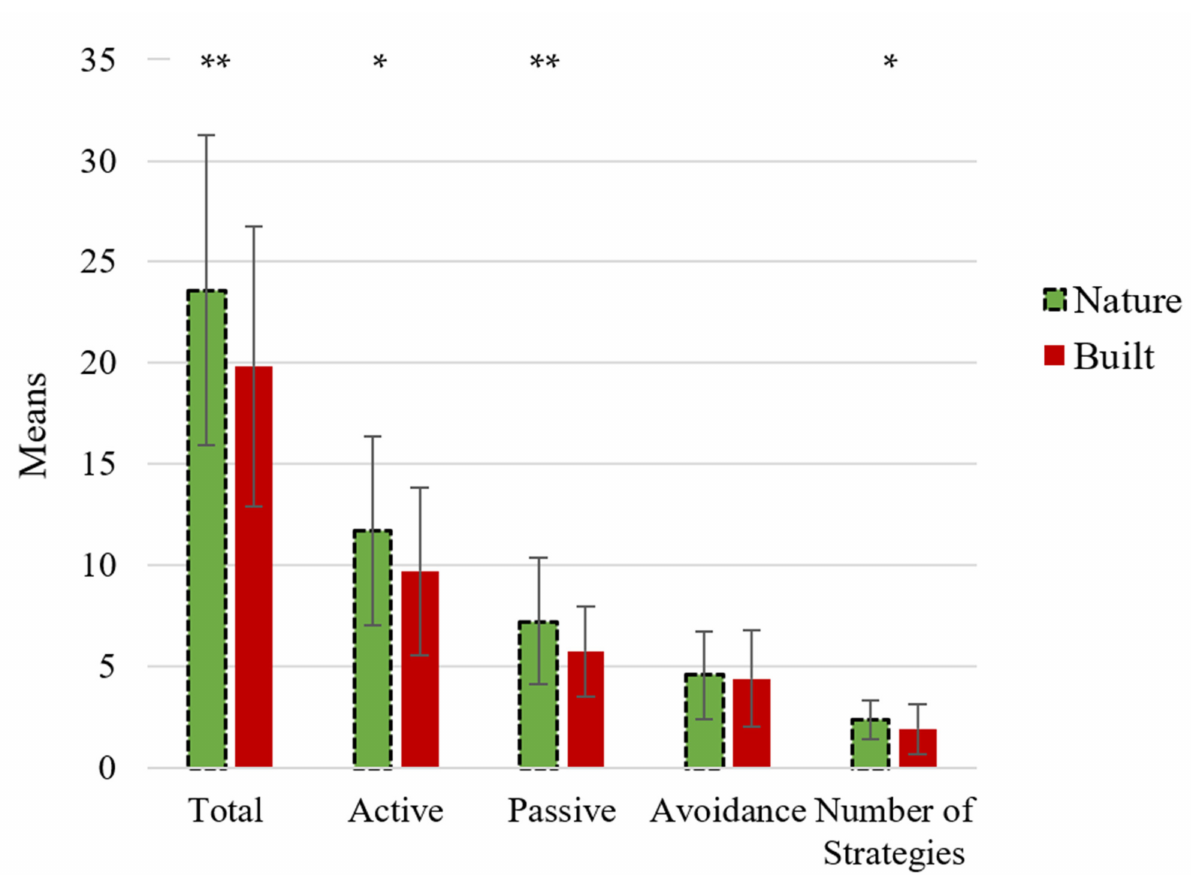
Figure 4. State Coping Scale (SCS) scores for the nature group and built group for Study 3. * p < 0.05 and ** p <